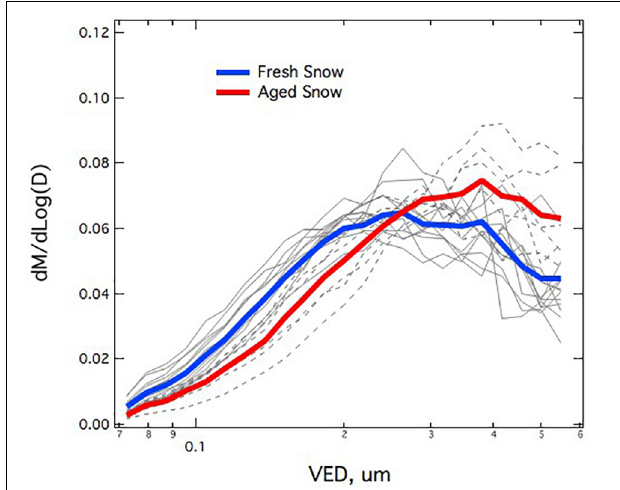
FIGURE 2 | Average size distributions of refractory black carbon (rBC) in fresh ( n = 6) and aged ( n = 6) snow on land samples from the Gokyo Valley, Nepal. The solid gray lines represent the size distributions of all fresh snow samples and the dotted lines represent all aged snow samples. The blue line is the fresh snow sample average and the red line is the aged sample